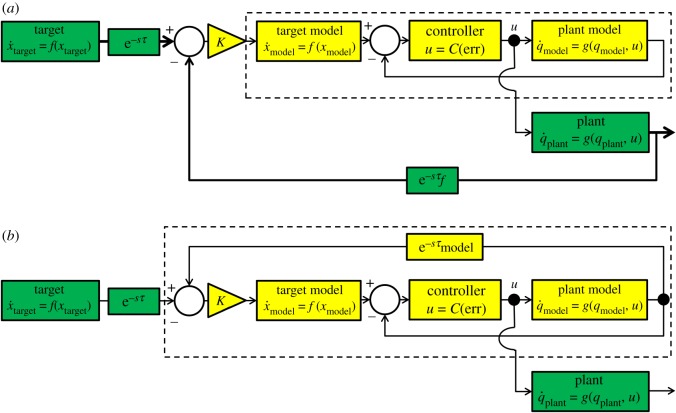
The serial system and an alternative system based on direct slave feedback. The internal slave model is delineated by a dashed box. Green blocks represent unchangeable elements of the underlying control loop, while yellow blocks have been added to enable anticipation. (a) The serial system. An internal model of the system’s dynamics acts as the ’slave’ in AS, while the output of the plant provides delayed self-feedback. The output of the model is a prediction of the future value of the err term, which is used to drive the controller without lag. (b) Alternative system where the delayed self-feedback is taken directly from the slave with an independent delay τmodel that must be tuned to closely match the sum of delays in the system. This entails the removal of feedback from the real slave.